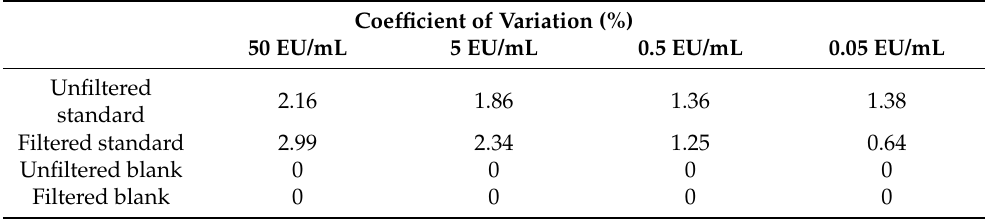
Table 1. Coefficient of variation (CV) among replicas of the filtered and unfiltered endotoxin standards (50, 5, 0.5, and 0.05 EU/mL) and blanks (endotoxin-free ultra-pure water).